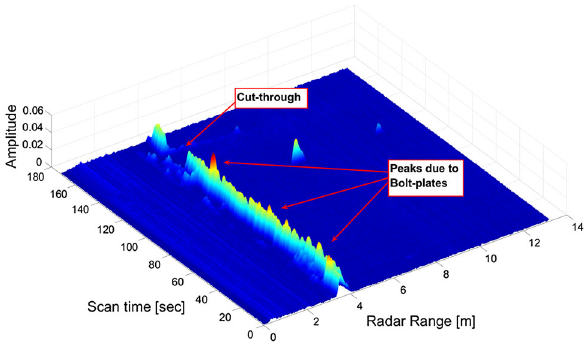
Fig. 8 Reconstructed radar data for a section of gate road with cut- though